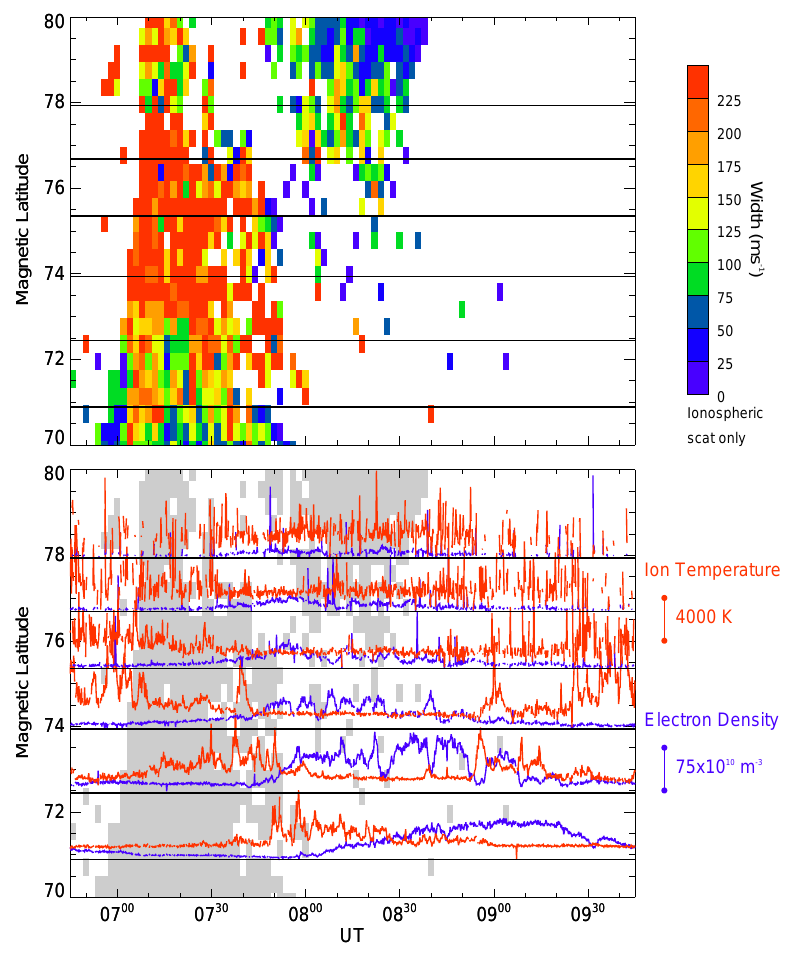
Fig. 6. The upper panel of this figure illustrates spectral width measurements from beam 7 of the CUTLASS Finland radar from 06:45 to 09:45UT on 23 November 1999 as a function of magnetic latitude. The lower panel illustrates, over the same time interval and latitude range, time series of F-region electron density (blue) and ion temperature (red) from selected range gates along beam 1 of the VHF radar. The horizontal back lines indicate the latitudes corresponding to these gates and act as their baseline levels, and the vertical lines, appropriately coloured, indicate the scales. The light grey shading shows, for guidance, the extent of the ionospheric scatter presented in the top panel.